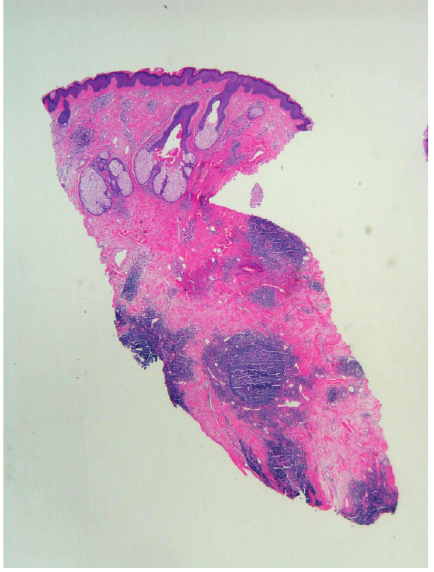
Figure 3: Histology.